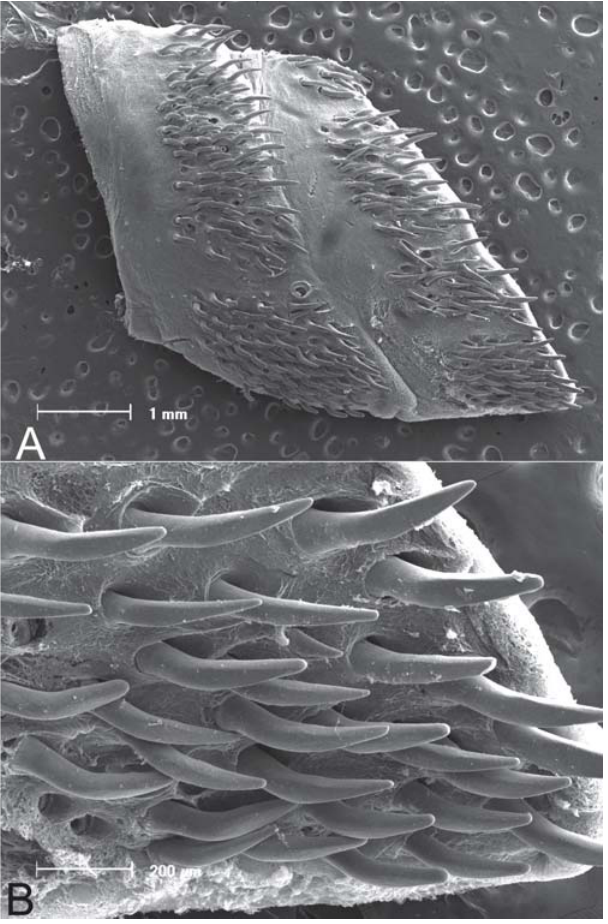
Fig. 6. Scanning electron micrographs of the body odontodes of Ixinandria steinbachi (MCNI 99, 65.9 mm SL). A) Two plates of the median and mid-ventral lateral series with odontodes; B) detail of odontodes.